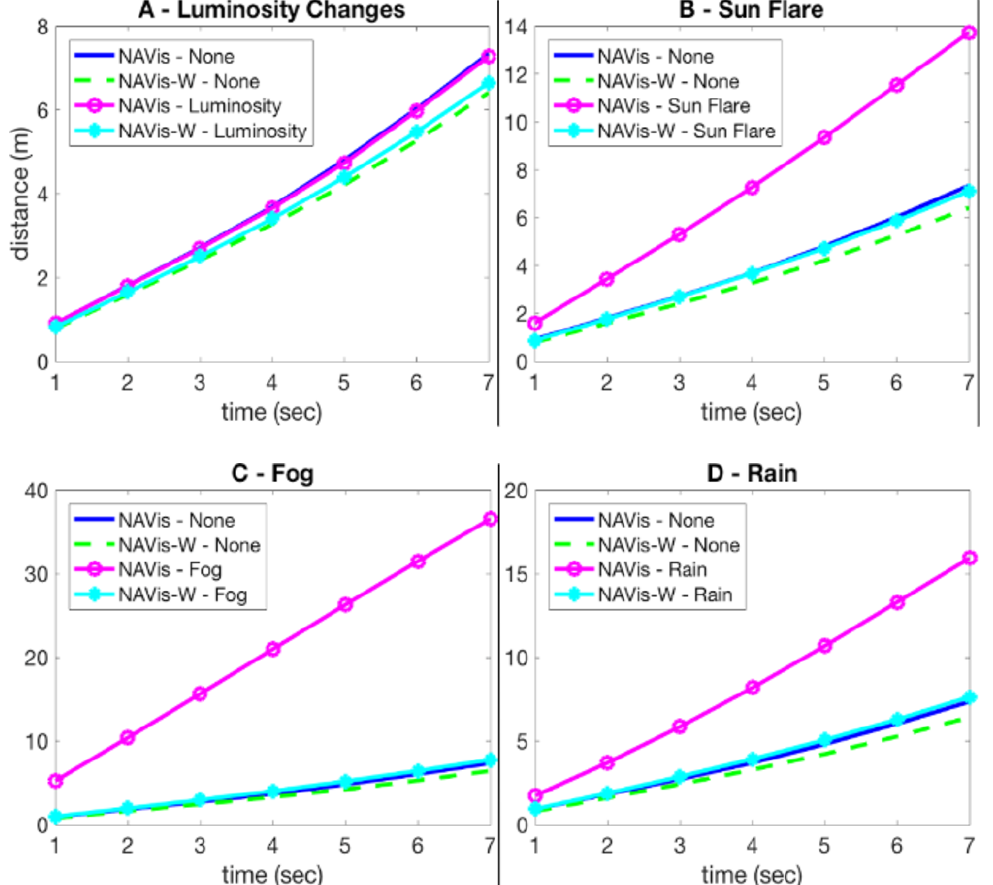
Figure 9. MAE (Mean Average Error) measured in seconds (sec) of predicted trajectories on changing environmental